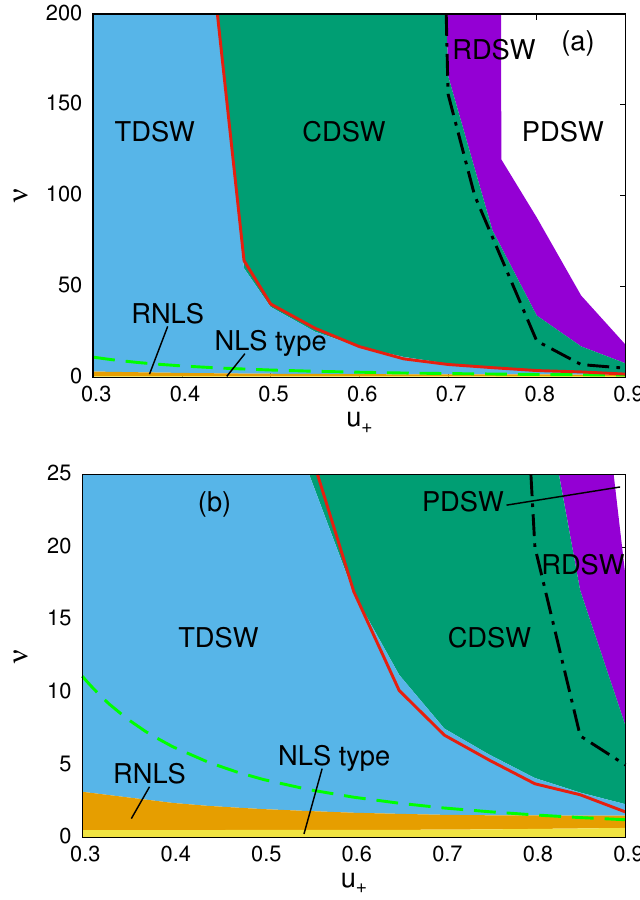
Figure 3. Numerical existence regions for nematic DSW types in terms of the nonlocality parameter ν as the initial level u + varies. ( a ) Full existence regions from highly nonlocal ν = 200 to local ν = 0, ( b ) Detail of ( a ) for the transition to an NLS-type DSW. Theoretical boundary (72) between RDSW and CDSW regimes: black (dot-dash) line; theoretical boundary U s = c g , (95), between CDSW and TDSW regimes: red (solid) line; theoretical boundary (43) between KdV-type and NLS-type DSW: green (dashed) line. Here, u − = 1.0 and q =